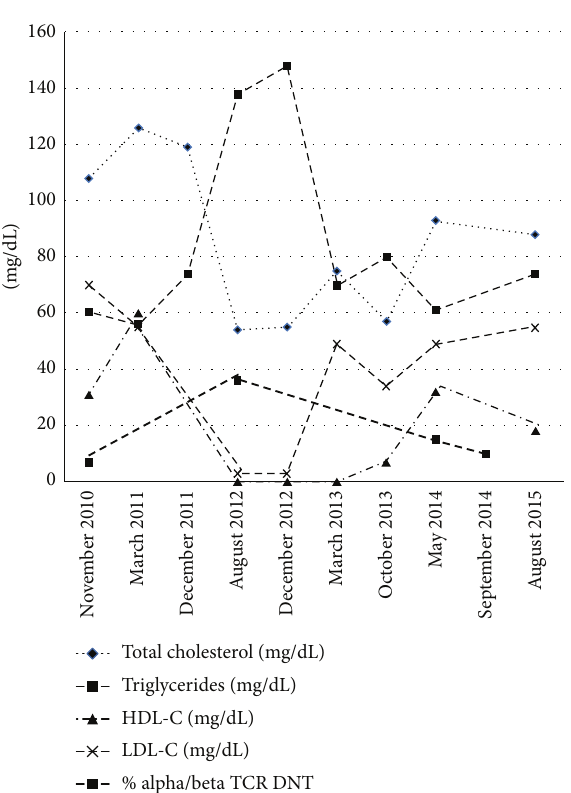
Figure 1: Relationship between lipid parameters and disease activity marker % alpha/beta